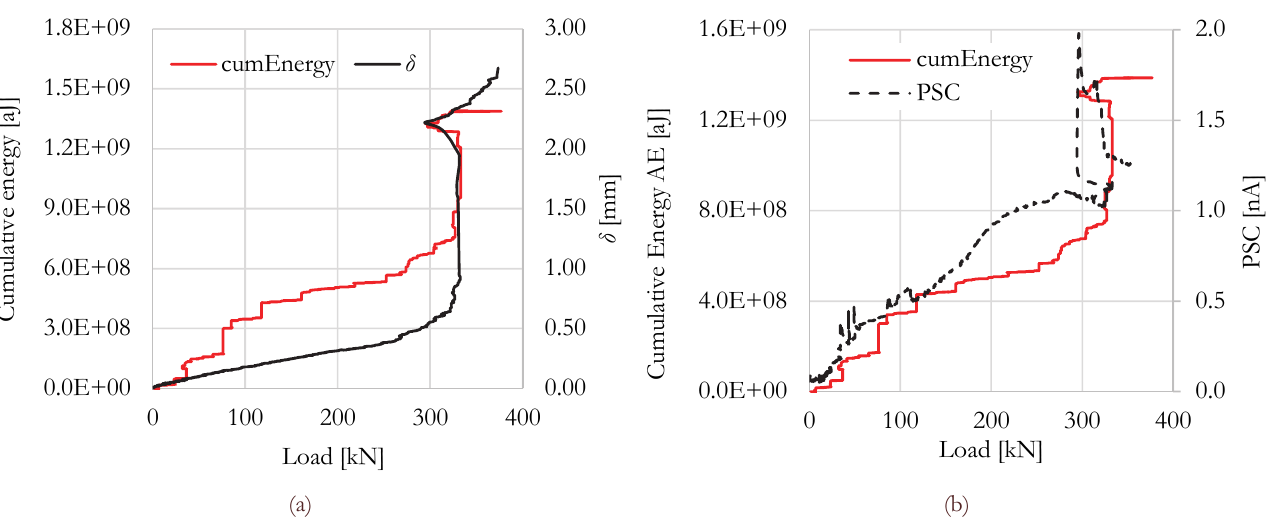
Figure 9: (a) The variation of the cumulative energy of the AE and δ versus the load applied; (b) The variation of the cumulative energy of the AE and PSC recordings versus the load